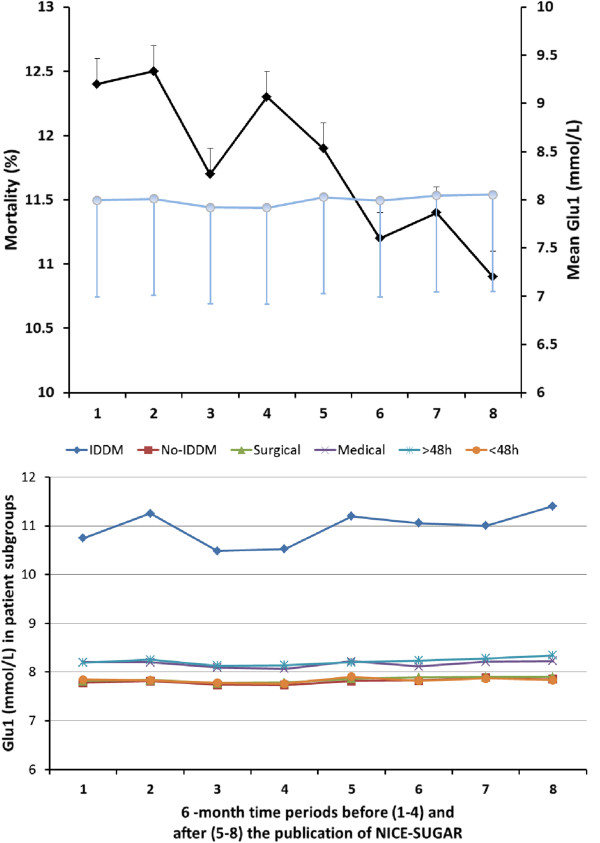
Glu1, mortality and Glu1 in subgroups over time before and after NICE-SUGAR. Mean first day glucose (SE, Glu1, blue circles) in all patients with crude hospital mortality (SE, black squares) in four consecutive six-month periods before (periods 1 to 4) and after (periods 5 to 8) Normoglycemia in Intensive Care Evaluation and Surviving Using Glucose Algorithm Regulation (NICE-SUGAR) study (upper panel). Mean Glu1 values in patient subgroups (surgical/medical, IDDM/no IDDM, ICU stay >48 h/ICU stay <48 h) in the same six-month periods (lower panel). IDDM, insulin-dependent diabetes mellitus.